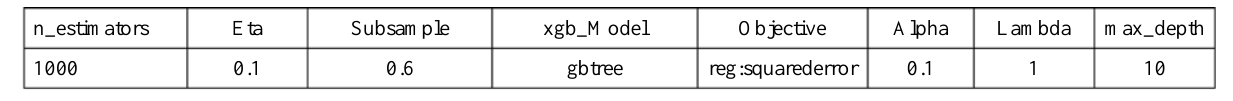
Table 3. The XGBoost parameters.